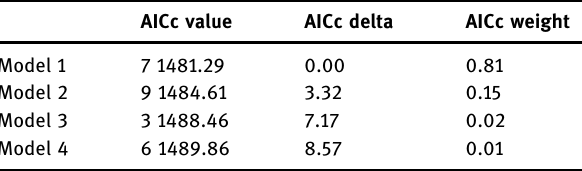
Table 2: Model selection for analysis of storage